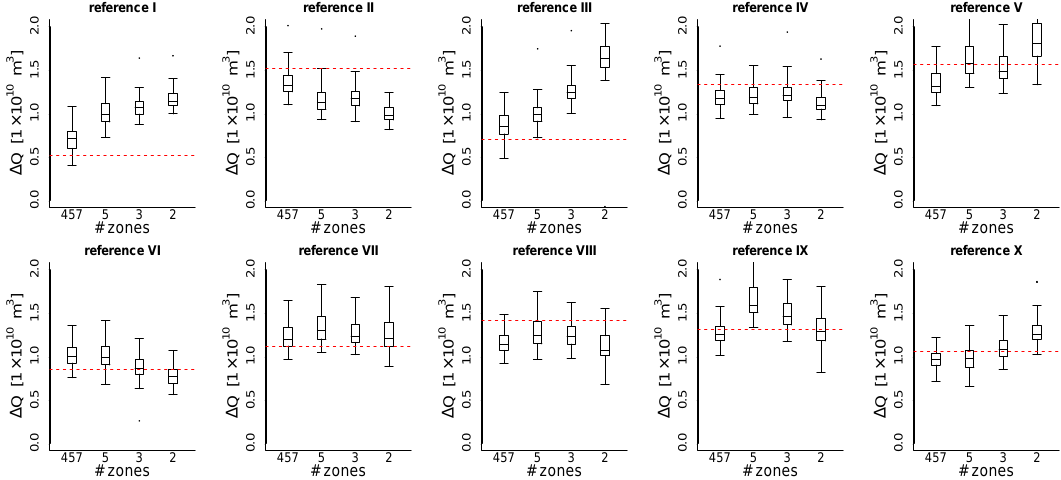
Fig. 15. Total amount of water exchanged between river and aquifer over the whole simulation period (609 days) for conditional simulations with EnKF (scenario D). Red lines mark the water exchange for the different reference runs.